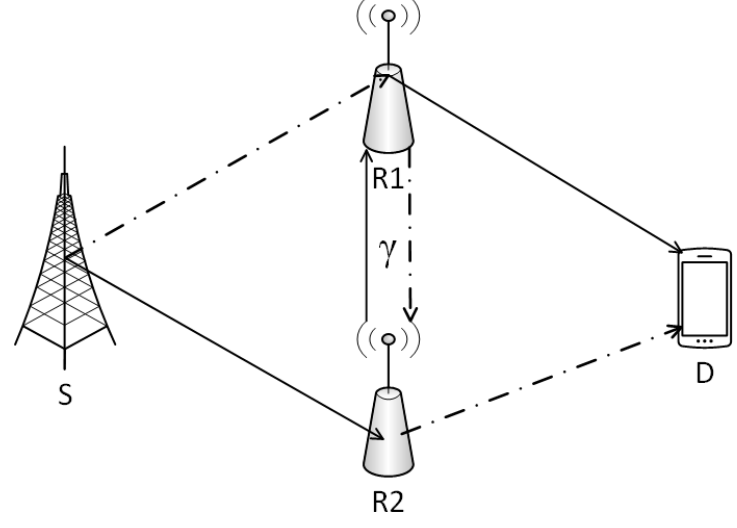
Figure 2. Virtual full-duplex relaying